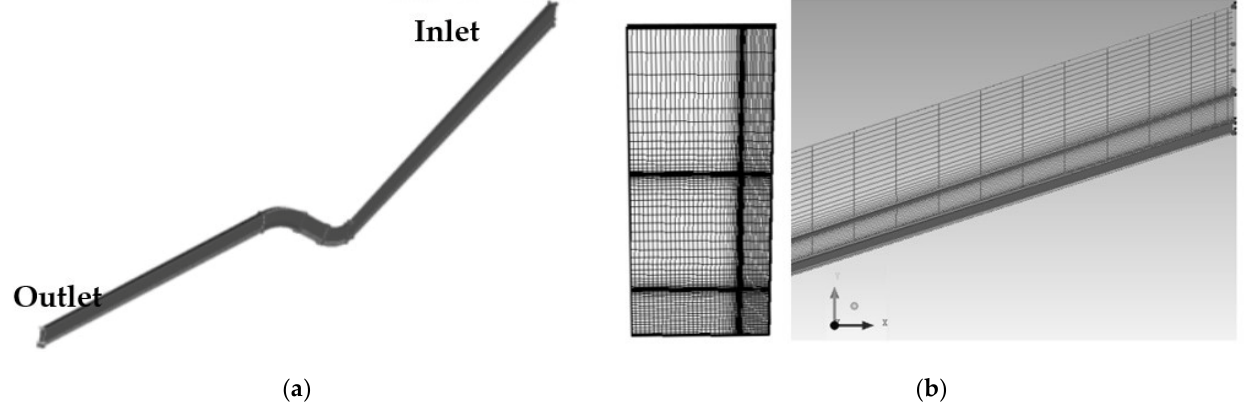
Figure 7. Numerical model: ( a ) View of the single cooling channel; ( b ) Details of transversal and axial mesh distribution in the throat section (left) and inlet section (right).